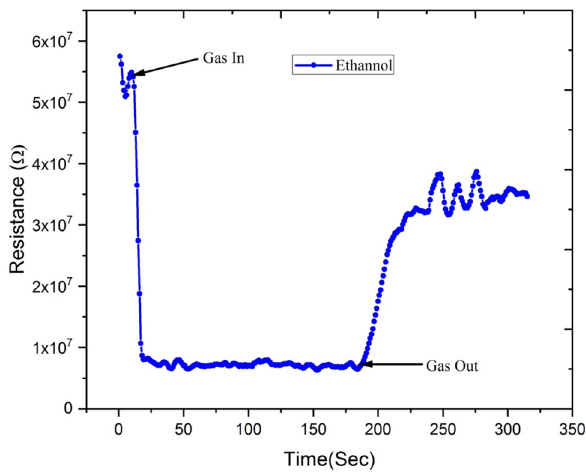
Figure 23. Variation of electrical resistance of Ga-doped ZnO thin film (Si 6+ ion irradiated at 5 × 10 13 ion fluence) with time for 250 ppm concentration of ethanol gas.